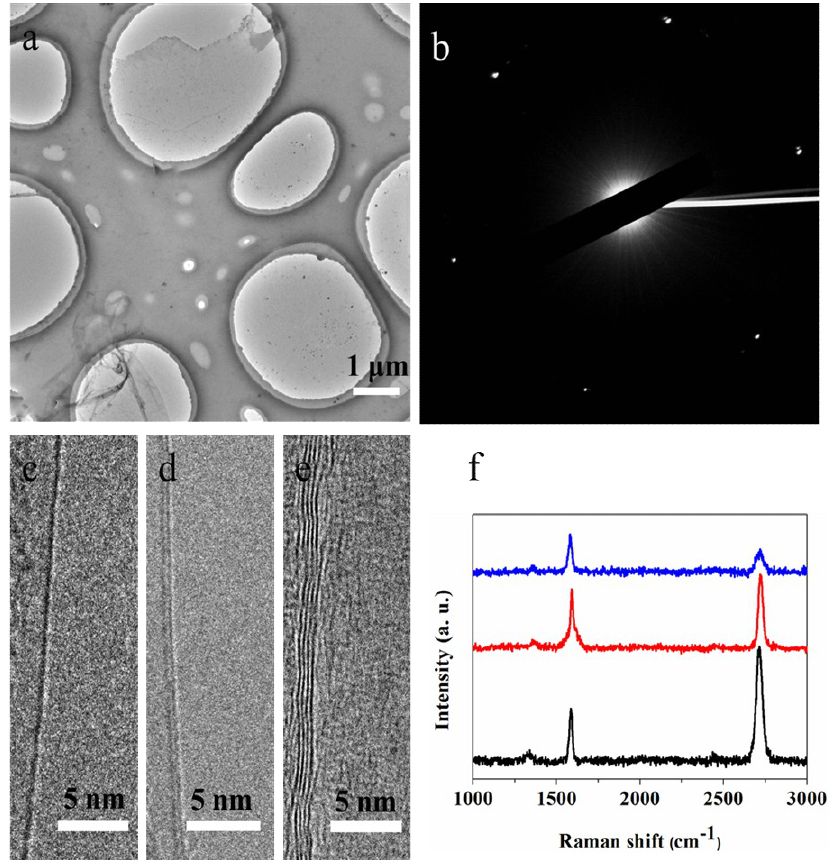
Figure 4. ( a ) TEM image of the graphene domain on the TEM grid. ( b ) Selected-area electron diffraction (SAED) pattern showing a single-crystalline nature of the U-shaped graphene domain. ( c – e ) TEM images of the layer number of graphene. ( f ) Ramen spectra of graphene domain on copper foil, showing monolayer and few-layer graphene on copper foil.